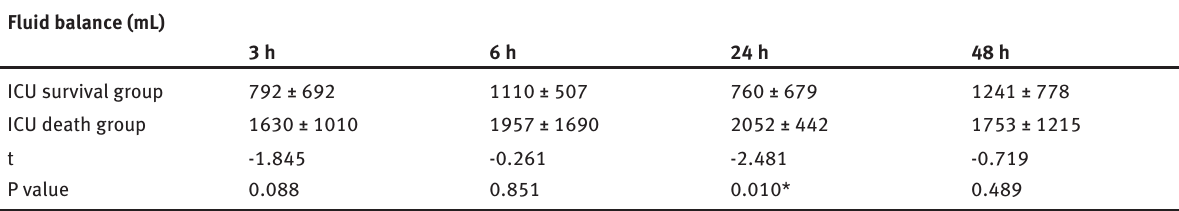
Table 5: Comparison of fluid balance between the ICU survival (n=11) and death (n=4) groups Fluid balance